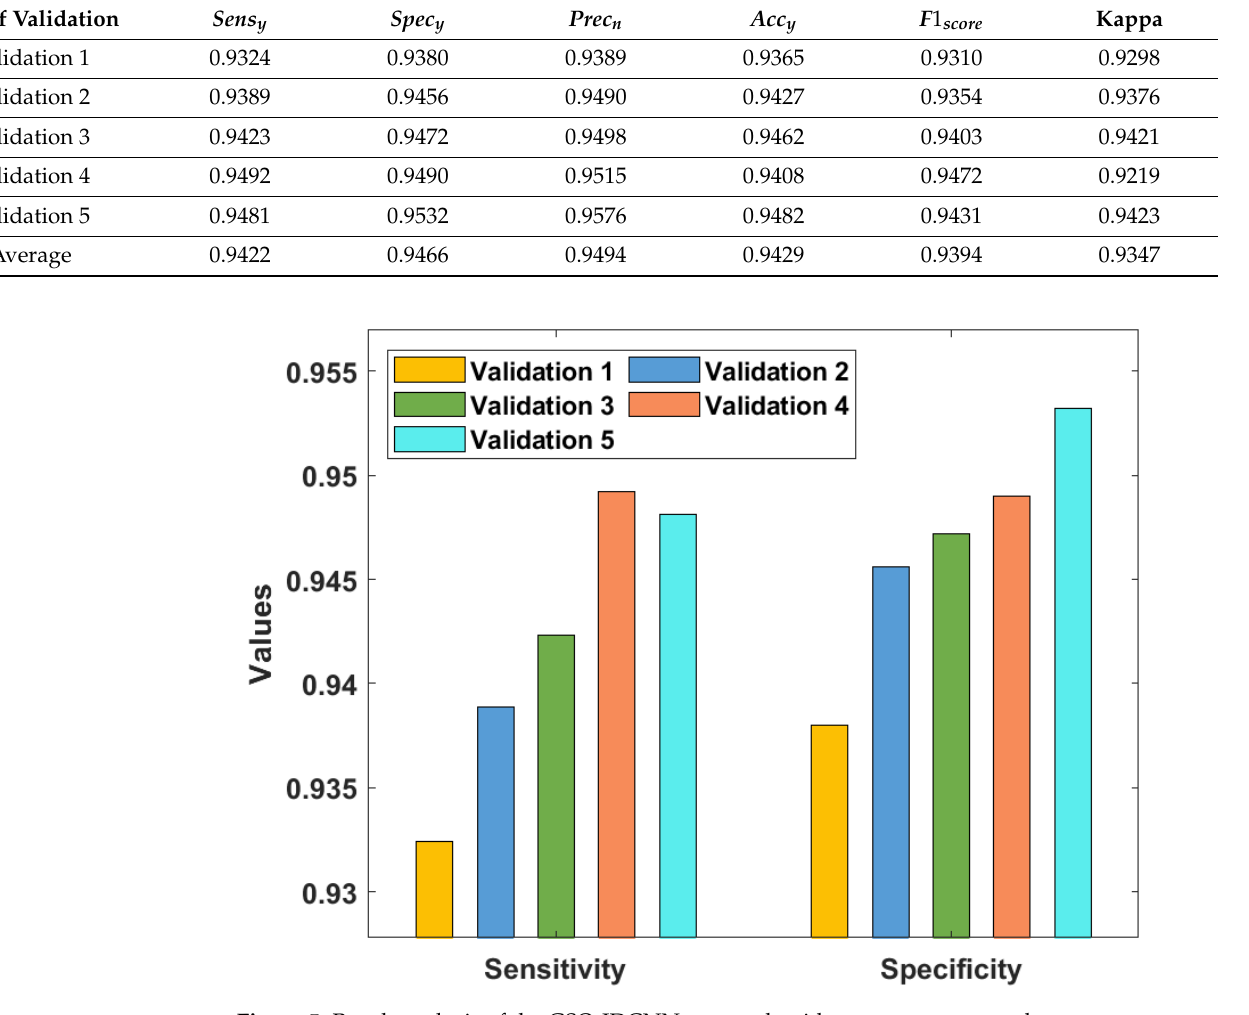
Table 1. Result analysis of the presented GSO-IDCNN technique with respect to distinct measures.